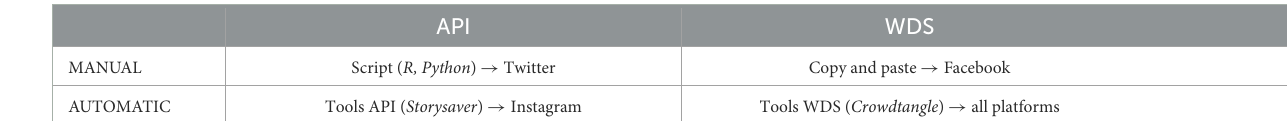
TABLE 1 Typology of data